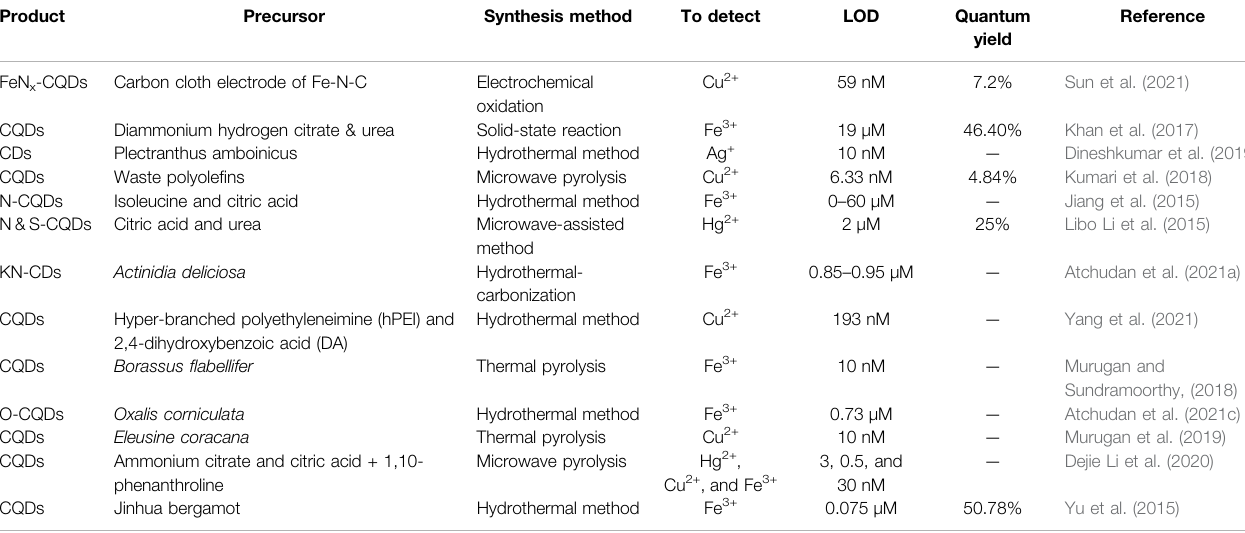
TABLE 1 | The CQDs synthesized from various precursors for sensor applications and measured parameters (LOD, QY, and heavy metal detection).